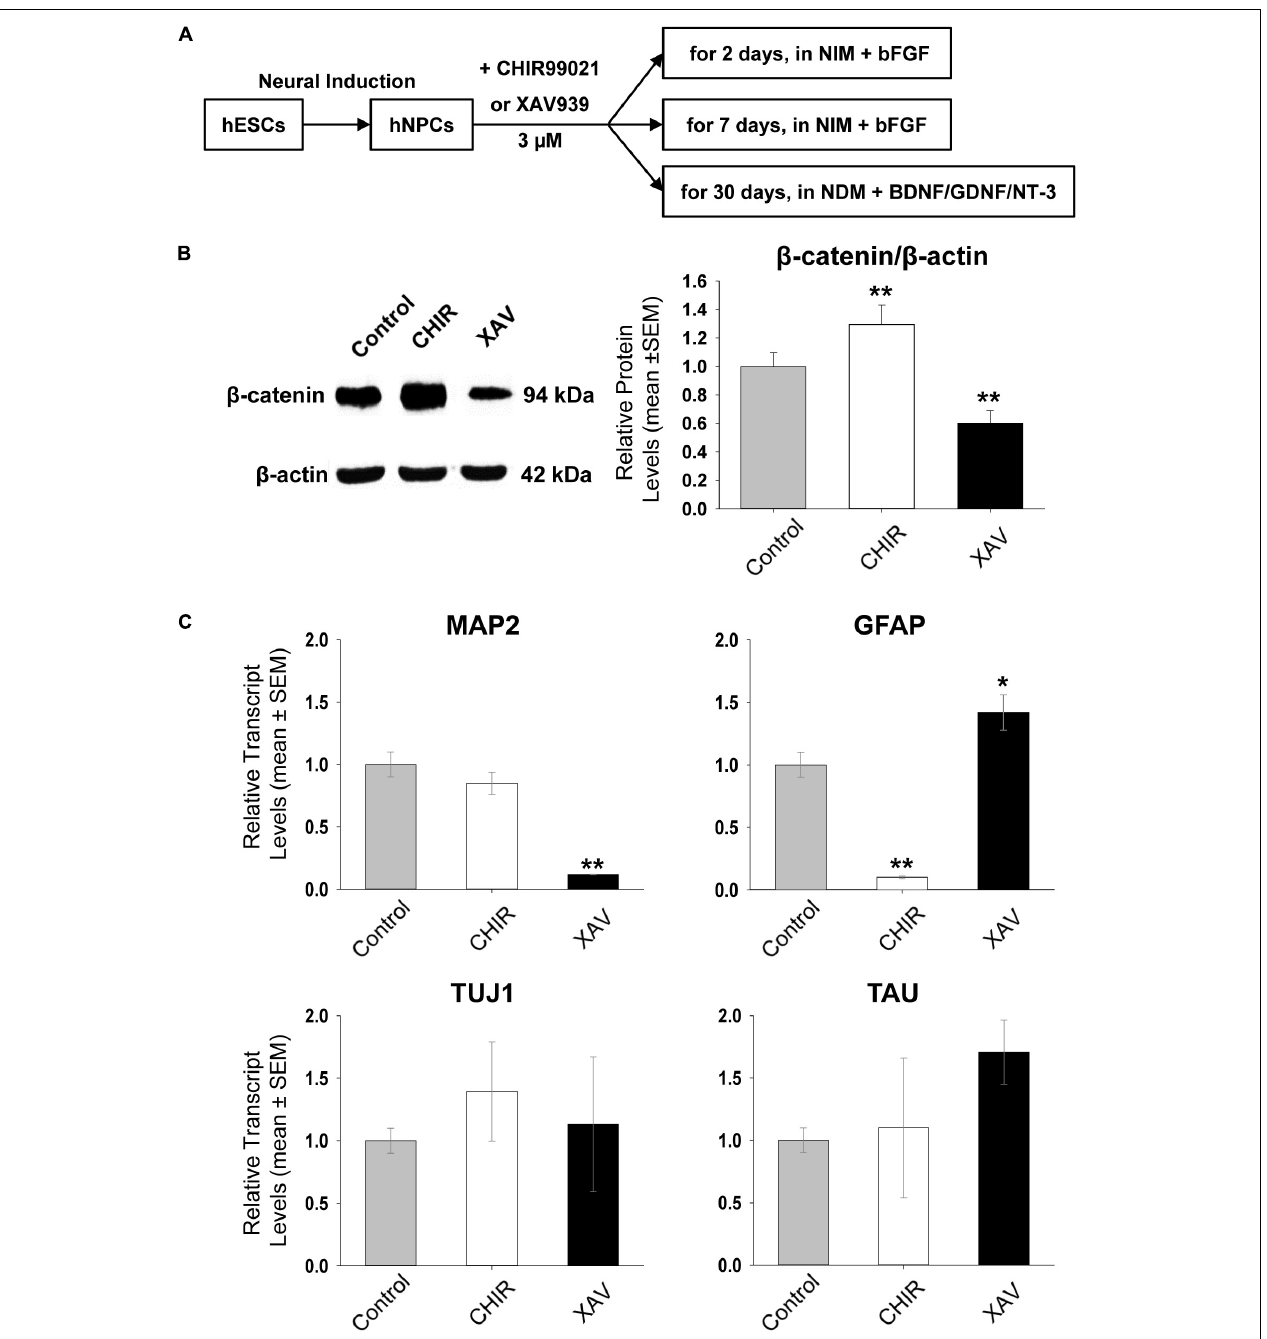
FIGURE 1 | Short-term effect of Wnt modulators on hNPCs. (A) Schematic outline of the experimental set-up. Human embryonic stem cells (hESCs) are differentiated into neural precursor cells (hNPCs), used to test the effects of 3 µ M CHIR99021 (CHIR) or XAV939 (XAV). hNPCs were either maintained in NIM containing basic fibroblast growth factor (bFGF), or in Neural Differentiation Medium (NDM) containing brain-derived neurotrophic factor (BDNF), glia-derived neurotrophic factor (GDNF) and neurotrophin-3 (NT-3). (B) Western blot analysis of β -catenin protein levels after treating hNPCs in NIM containing bFGF with 3 µ M CHIR or XAV for 2 days. β -actin was used as loading and normalizing control. Left representative images for Western blots, obtained in HUES13-hNPC line. Gel images were used to establish mean gray value (MGV) in regions of interest of equal surface size (densitometry). Right Quantification of β -catenin/ β -actin MGV ratio, normalized to control (control: gray bars, CHIR: white bars, XAV: black bars). Values are mean ± SEM. Experiments repeated three times in 4 hNPC lines, ** p < 0.01, ANOVA. (C) Effect of treatment with 3 µ M CHIR or XAV for 2 days on the transcriptional status of neural genes. qRT-PCR measurement of MAP2, GFAP, TUJ1, and TAU relative transcript levels (“ (cid:49)(cid:49) Ct”), using the housekeeping gene GAPDH as an internal control (control: gray bars, CHIR: white bars, XAV: black bars). Experiments repeated three times in 4 hNPC lines. Values are mean ± SEM, * p < 0.05; ** p < 0.01, ANOVA.